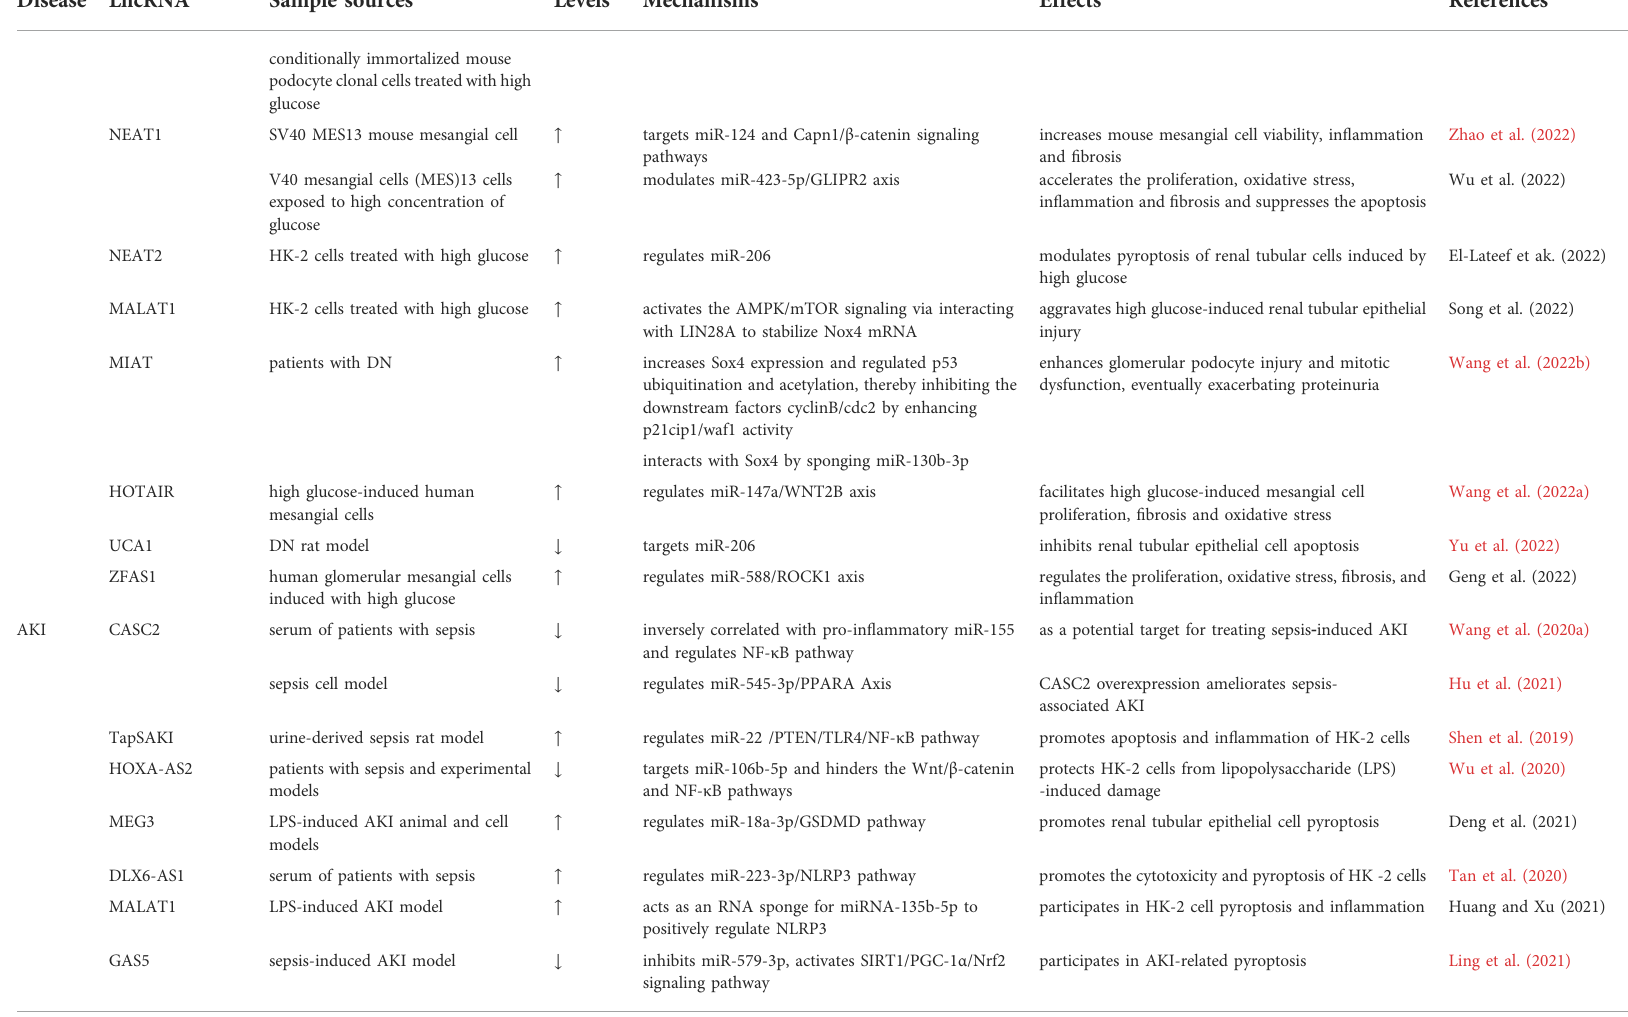
TABLE 1 ( Continued ) Levels, effects and functions of lncRNAs in experiments in kidney